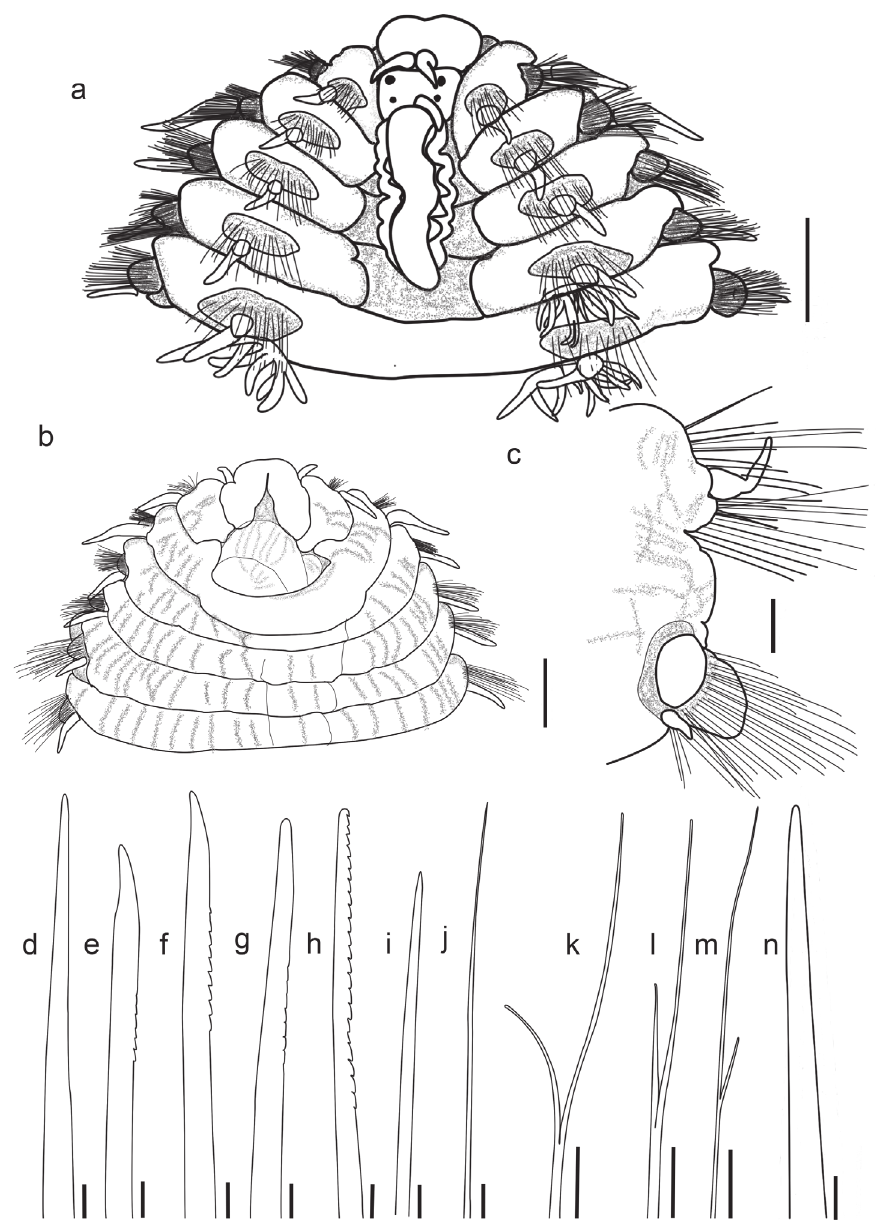
Figure 2. Alleurythoe tenuichaeta gen. n. & sp. n., holotype. a Anterior chaetigers, dorsal view b Anterior chaetigers, ventral view c Parapodia of middle chaetiger, posterior view d Greatly reduced harpoon chaeta, notopodium of chaetiger 5 e–g Reduced harpoon chaeta, notopodium of chaetiger 14 h Harpoon chaeta, notopodium of chaetiger 106 i Acicula, notopodium of chaetiger 106 j Capillary chaeta, neuropodium of chaetiger 85 k Bifurcate chaeta, neuropodium of chaetiger 22 l–m Bifurcate chaetae, neuropodium of chaetiger 85 n Simple chaeta, neuropodium of chaetiger 85. Scale bars: a–b 1 mm; c 0.5 mm; d–n 50